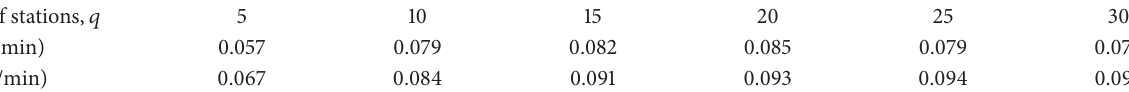
Table 4: Comparison of mathematical model of productivity with actual productivity.